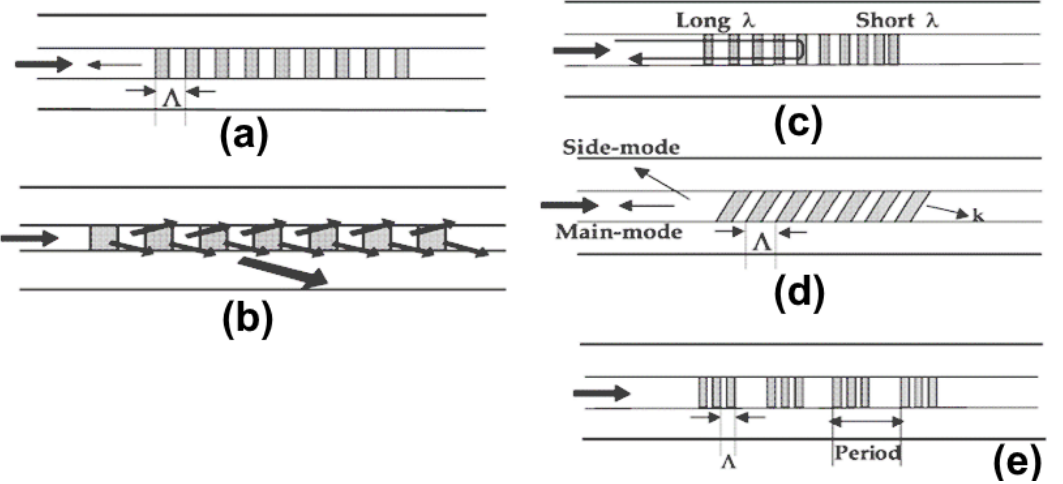
Figure 10. Types of fiber gratings. ( a ) Fiber Bragg grating; ( b ) long-period fiber grating; ( c ) chirped fiber grating; ( d ) tilted fiber grating; ( e ) sampled fiber grating